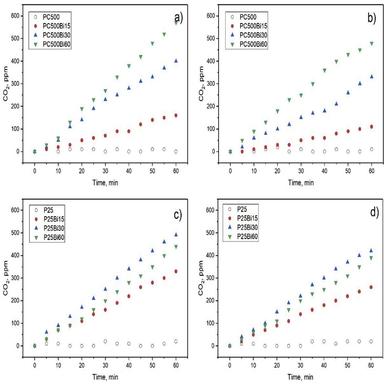
Results for photocatalytic CO2 evolution under visible light irradiation: a) acetone degradation by PC500-based samples; b) methanol degradation by PC500-based samples; c) acetone degradation by P25-based samples; d) methanol degradation by P25-based samples